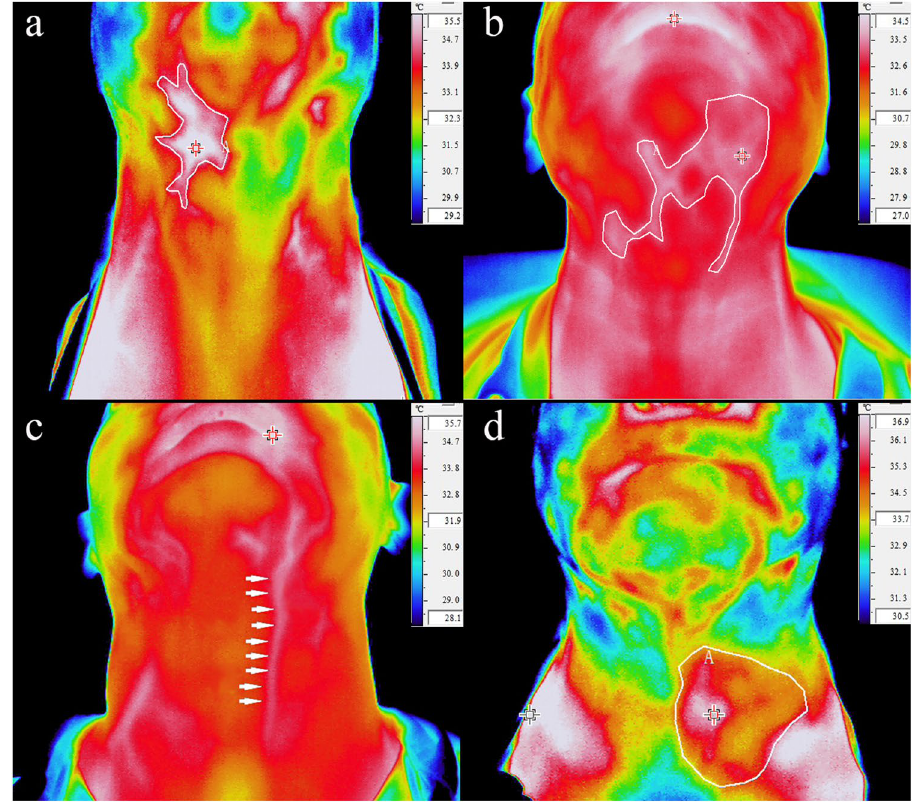
Figure 2. Manual qualitative analysis of IR imaging. ( a ) An asymmetric thermographic pattern that includes an elevated surface temperature and a vascular pattern; ( b ) Increased vascular density with a tortuous vascular morphologic pattern; ( c ) A unilateral dilated vascular image; ( d ) A surface temperature difference of over 1